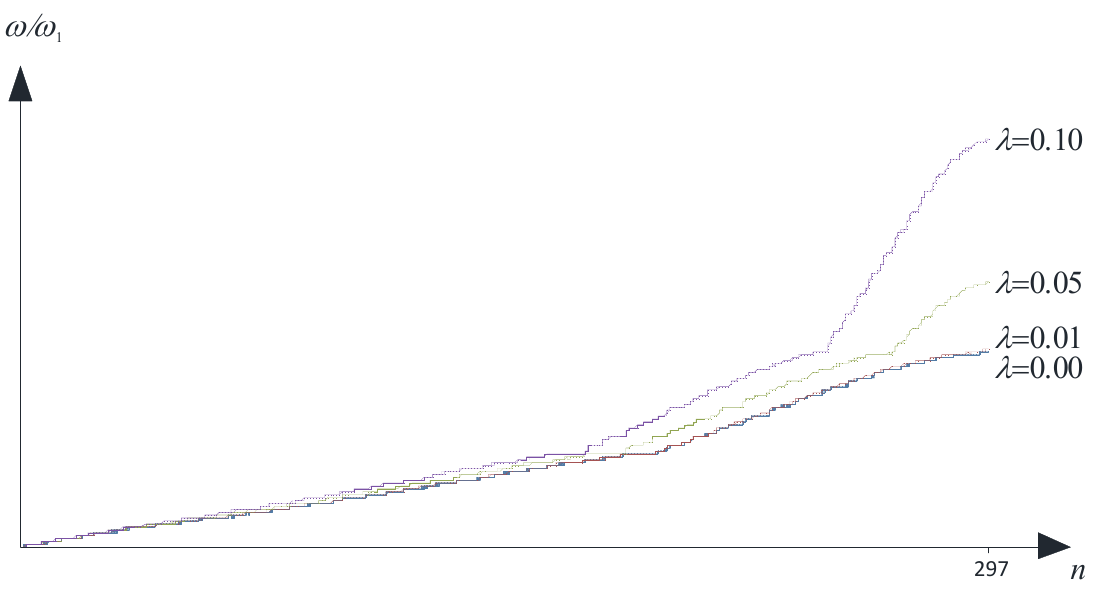
Figure 5. Dimensionless frequencies versus n (fixed point on the boundary